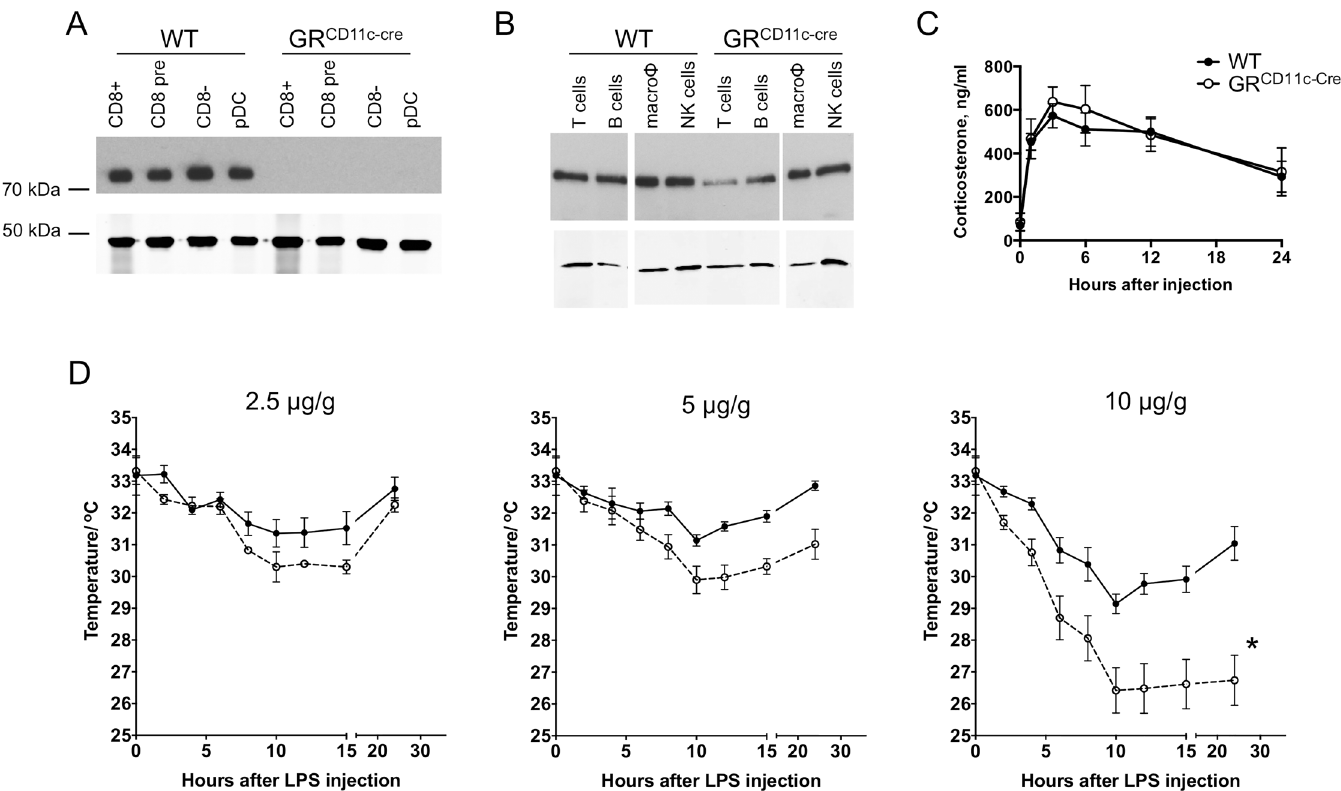
Fig 1. GR CD11c-cre mice are more susceptible to LPS-induced septic shock than WT. (A) and (B) Immunoblot for GR in sorted DCs and other immune subsets from WT and GR CD11c-cre mice. β -Actin was blotted as loading control. Some lanes were reordered for clarity, which is indicated by vertical white lines. (C) Plasma corticosterone concentrations after LPS challenge. Age- and sex-matched WT and GR CD11c-cre mice were injected with LPS (3 μ g/g body weight), and blood was drawn at indicated time points. Data shown are from four to eight animals per strain per time point pooled from multiple independent experiments. (D) GR CD11c-cre mice ( n = 4 – 6 per strain for each dose of LPS) were injected with the indicated amount of LPS, surface body temperature was recorded at the indicated times. * Four out of five GR CD11c-cre mice died by 24 hr after LPS challenge. The data used to make this figure can be found in S1